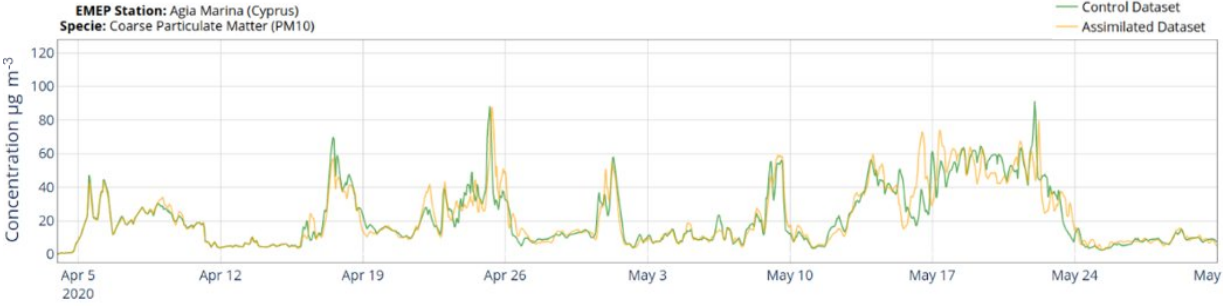
Figure A2. Comparison of PM 10 at the EMEP Station at Agia Marina, Cyprus, between the WRF-Chem simulations in spring, where the green line represents the control run and the yellow shows the assimilated